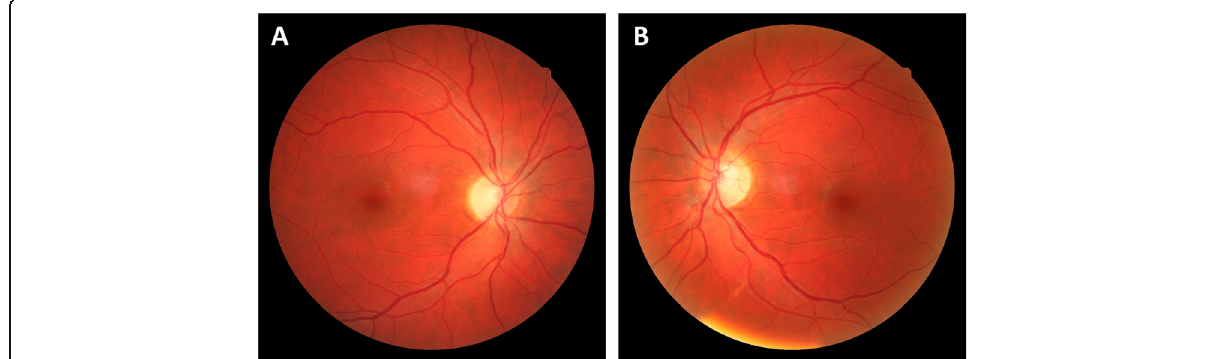
Fig. 1 Eye fundi. Temporal pallor of discs is seen in the right eye ( a ) and the left eye ( b ) of the affected